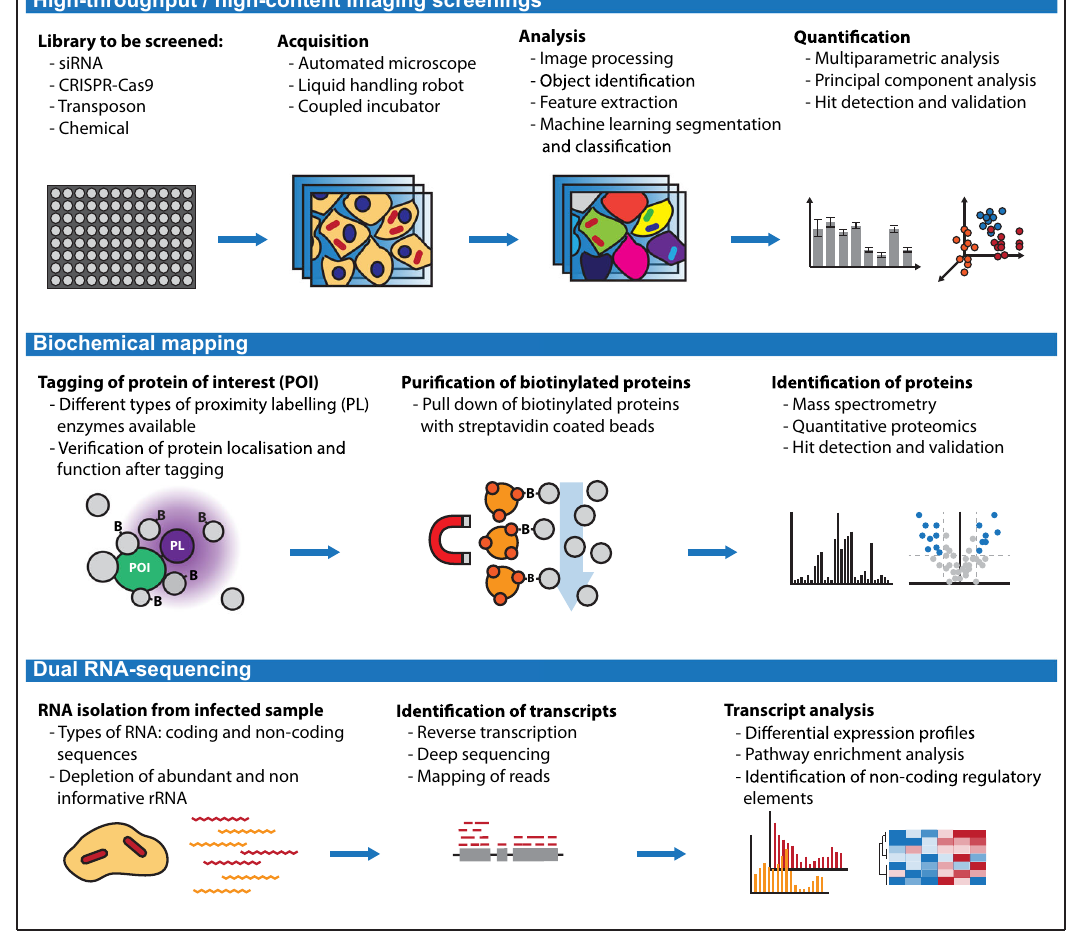
Fig. 2 Scheme comparing advanced approaches to discover host and pathogen factors underlying infection. (Top) High-throughput microscopy usually screens for chemicals, host or bacterial factors that impact bacterial replication, dissemination or fi tness. (Middle) Biochemical mapping, a proteomic screening approach to identify interaction partners of host and bacterial proteins of interest. (Bottom) Dual RNA-sequencing for the identi fi cation of differentially expressed transcripts from the host and